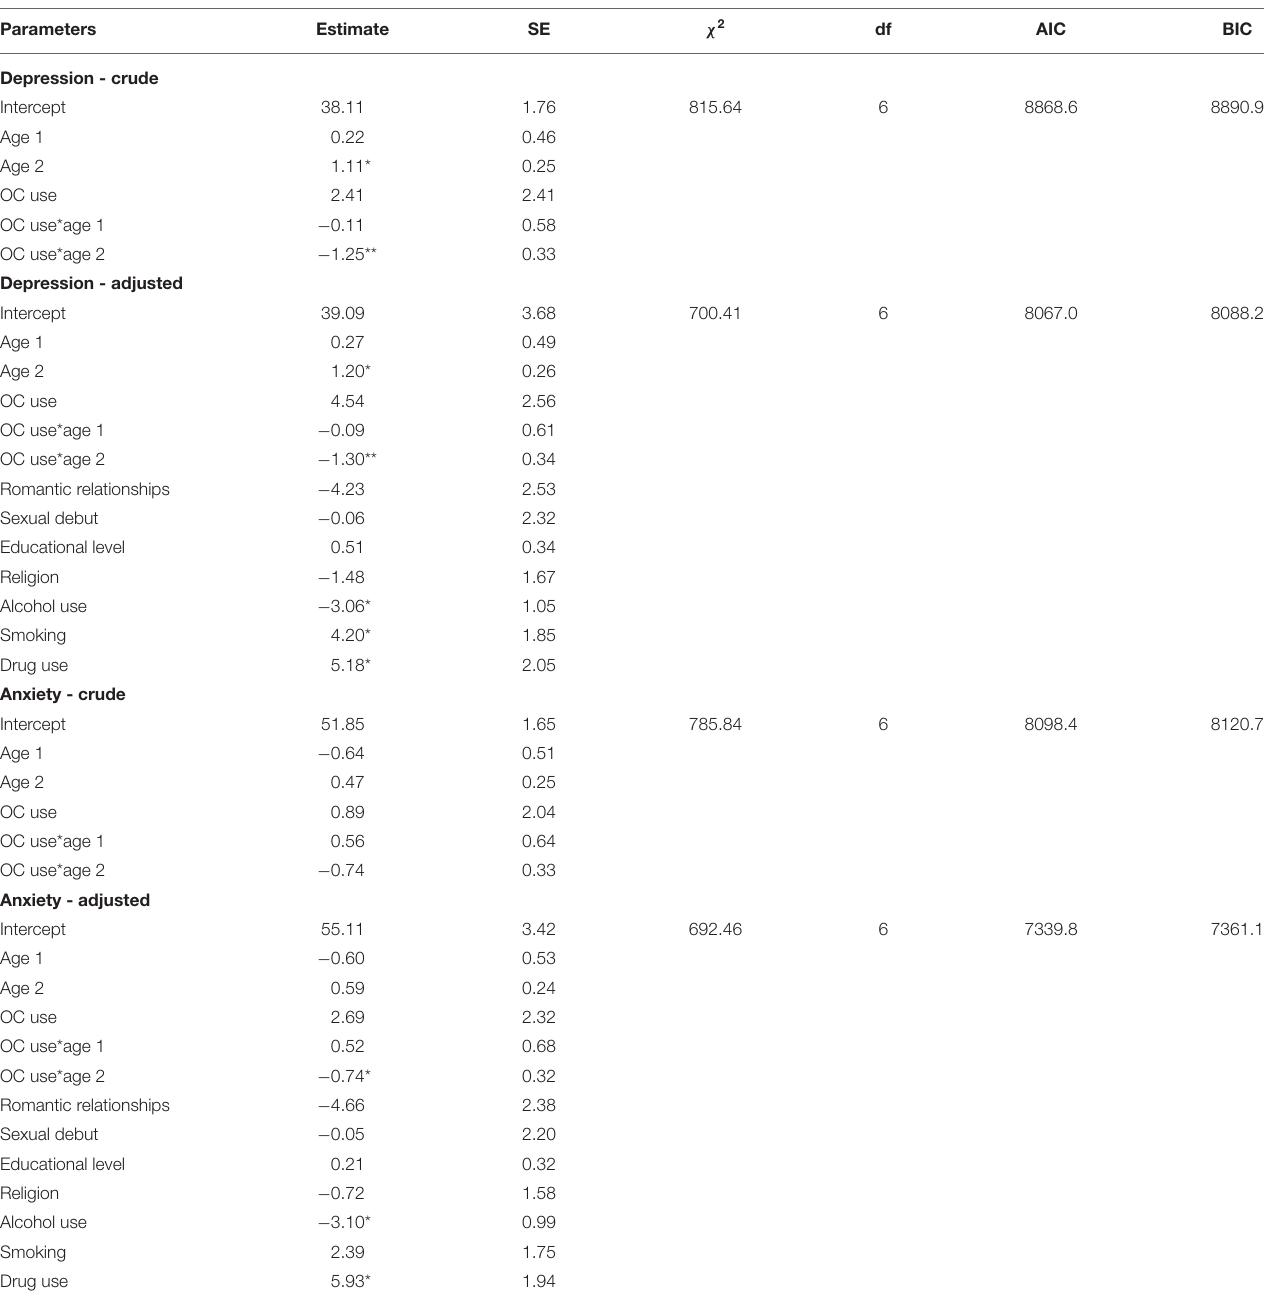
TABLE 3 | Model fit, standardized regression coefficients and standard errors of fixed and random effects as predictors of development of depressive and anxiety symptoms with never and ever users of oral contraceptives.